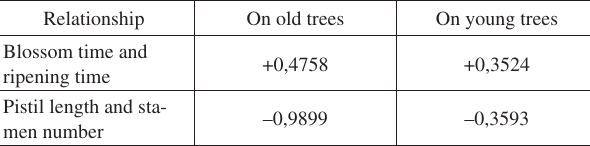
r-value between old and young trees